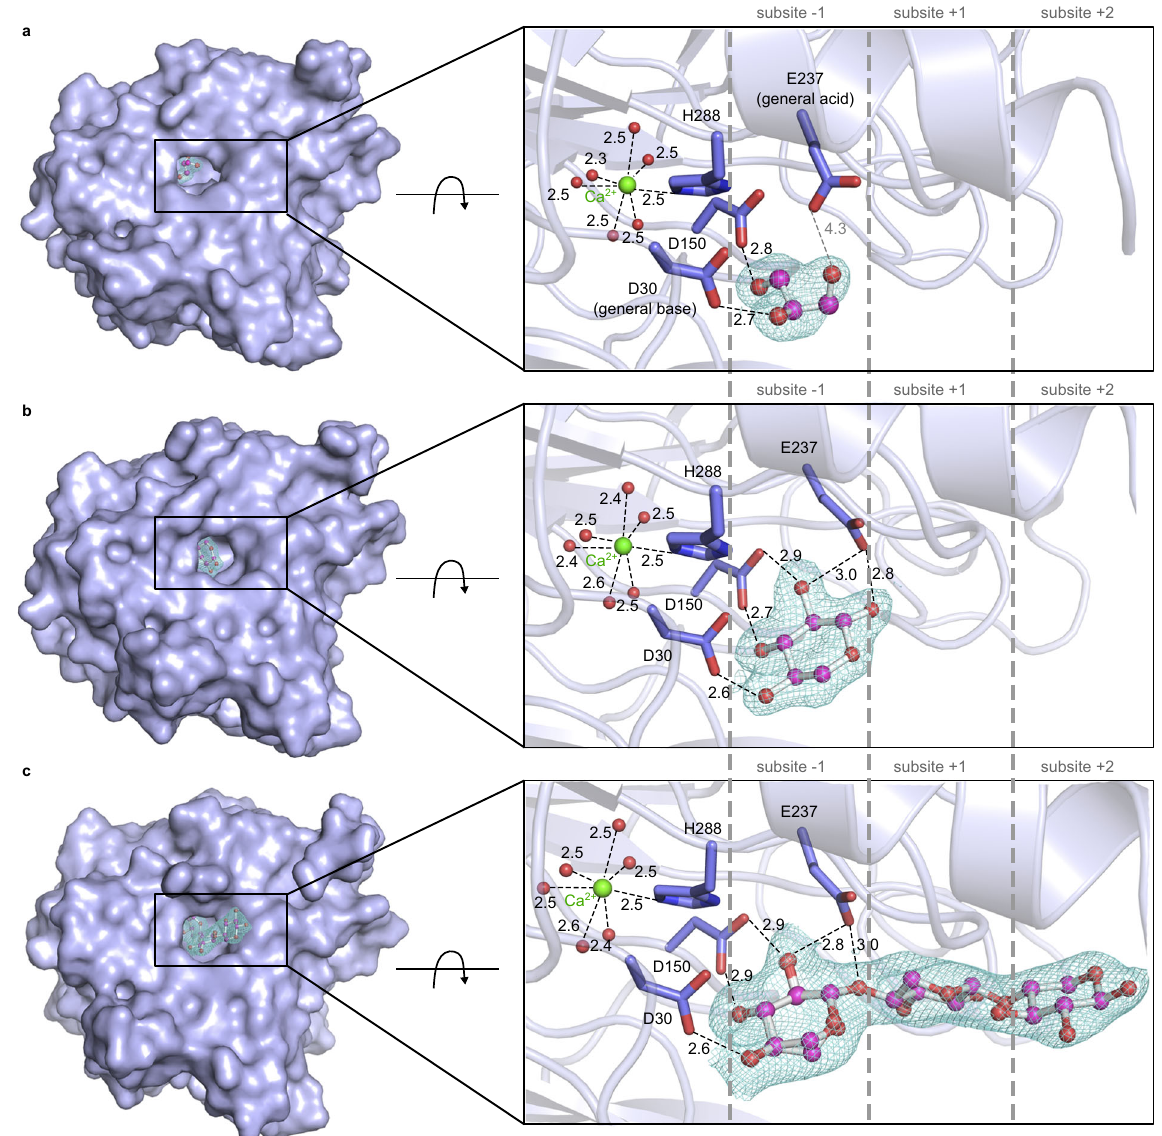
Fig. 3 Crystal structures of XacGH43_1. Structure of XacGH43_1 without sugar ( a ), where a glycerol molecule occupies the -1 subsite; in complex with xylose ( b ) and in complex with xylotriose ( c ). In all structures, the main interactions in the − 1 subsite and with Ca 2 + (green sphere) are shown with distances in angstroms. Water molecules coordinating the Ca 2 + are also shown (red spheres). The 2F o -F c electron density maps of ligands are shown with contour level of 1.0 σ , after re fi nement. Subsites numbering scheme follows the previously proposed 91,92